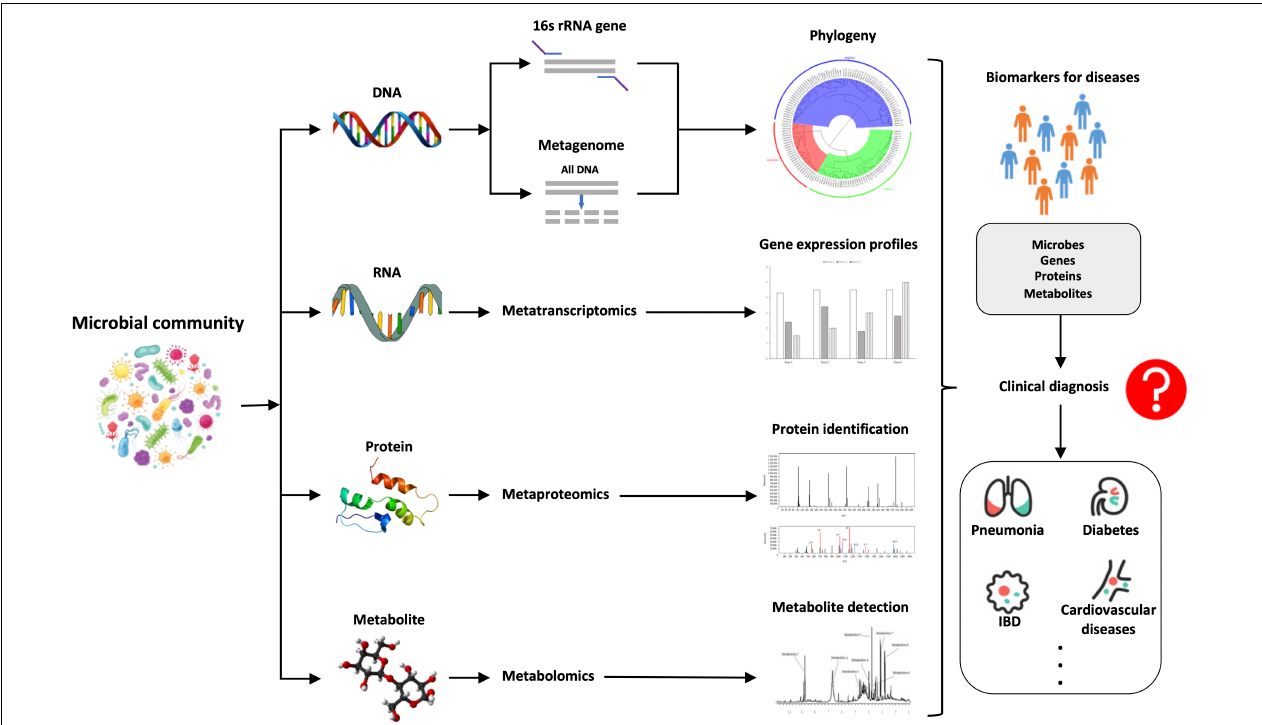
FIGURE 2 | A brief summary of the comparative illustration of the integration of the four metaomics approaches, that is, metagenomics (DNA), metatranscriptomics (RNA), metaproteomics (proteins), and metabolomics (metabolites), through which novel biomarkers such as microbes, genes, proteins, and metabolites could be identified, which might have the potential to be used for the rapid and accurate diagnosis of human diseases caused by microbiota